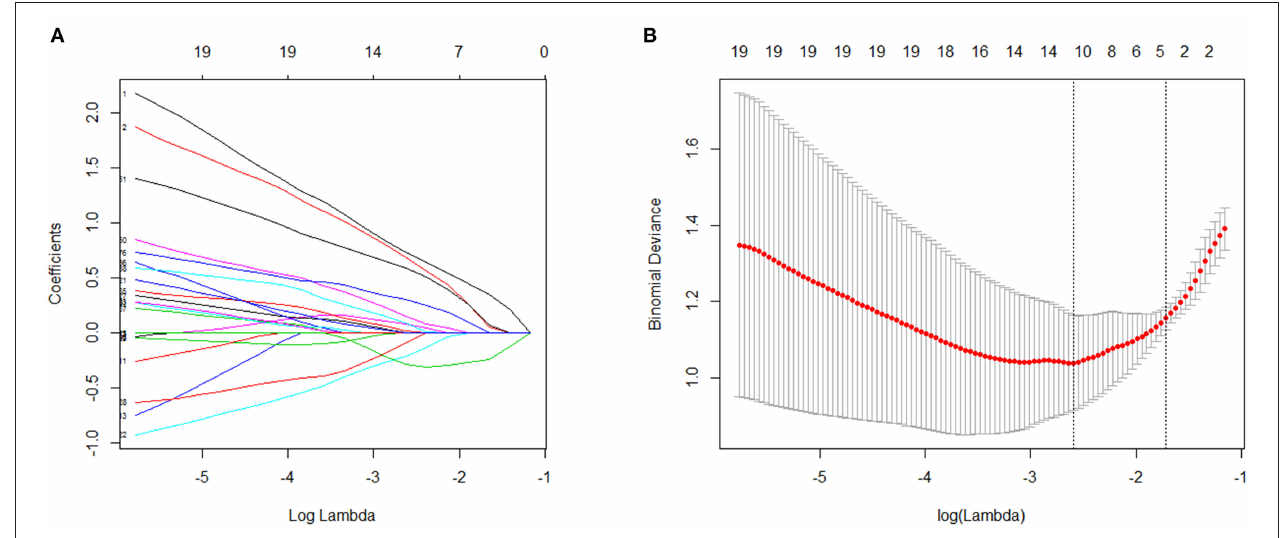
FIGURE 4 | Validation screened by Lasso. (A) The changes of coefficients with parameters were plotted in Lasso regression. (B) The change diagram of binomial device with parameter ln λ was drawn through 3-folds cross validation.